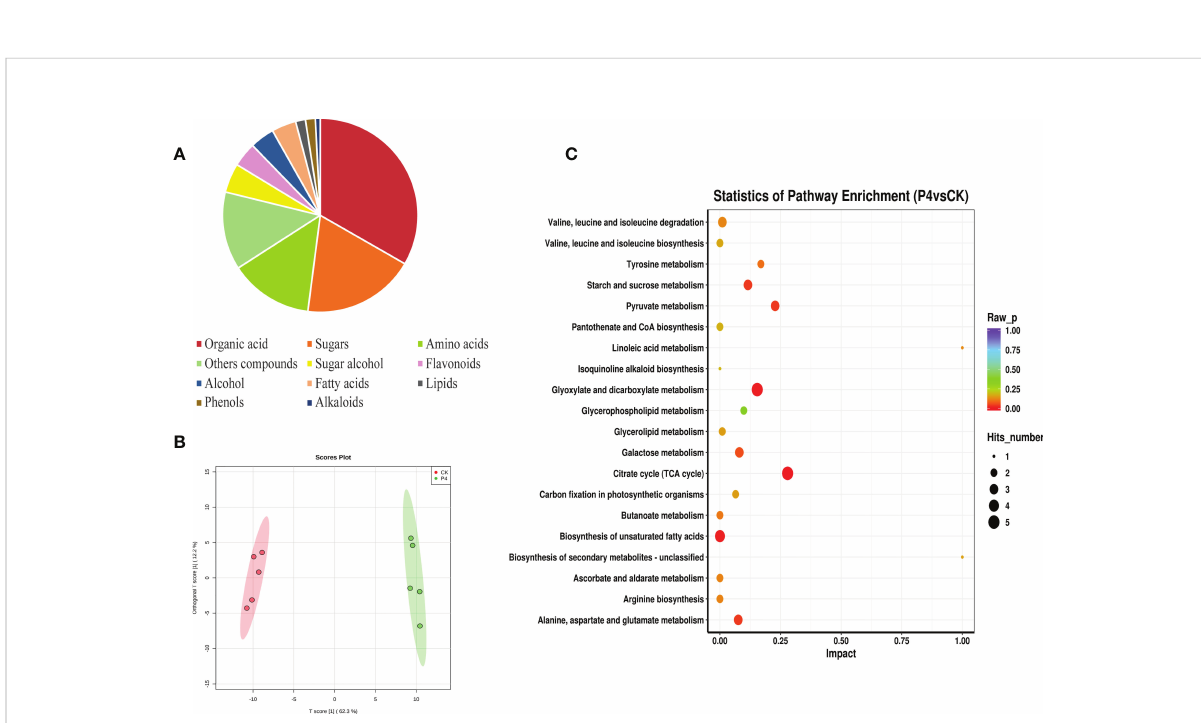
FIGURE 4 Metabolic pro fi le of plant compounds. (A) Classi fi cation and (B) PLS-DA score plot of metabolite. (C) In fl uence factors of metabolic